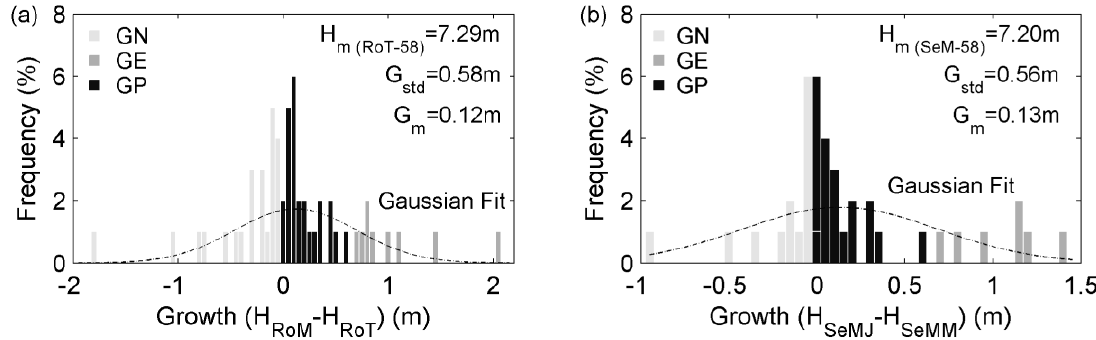
Figure 6. Histogram of the one-month height growths derived ( a ) from the RoT and RoM surveys and ( b ) from the SeMM and SeMJ surveys. See text for the definition of